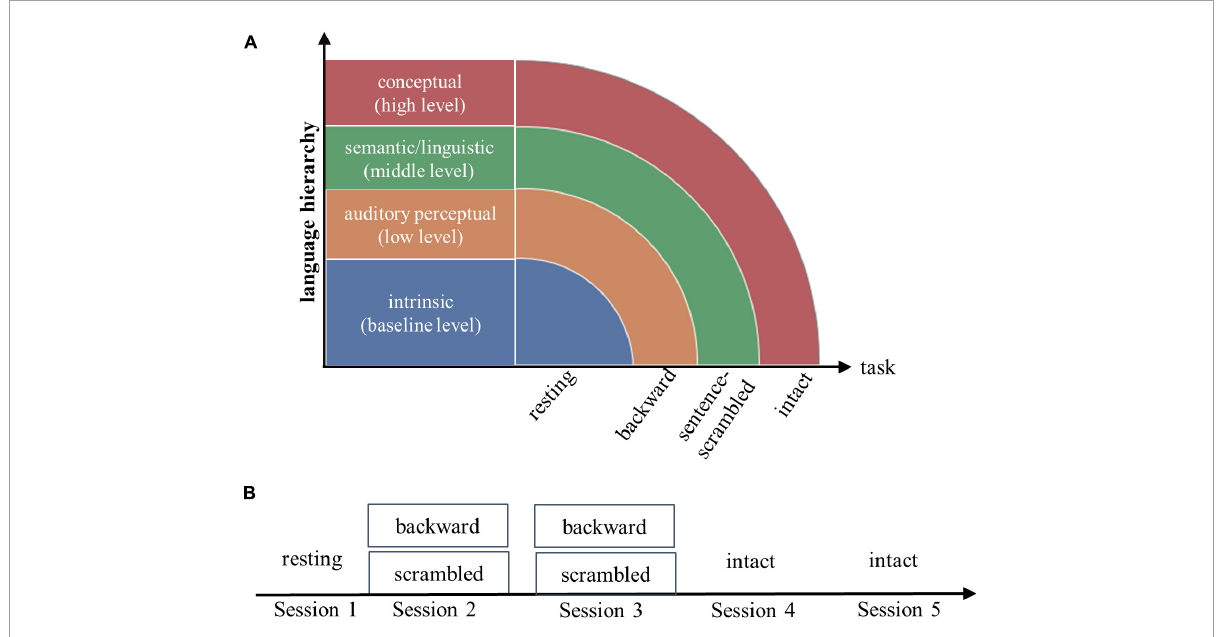
FIGURE1 Experimental design (A) and fMRI scanning scheme (B) . Each subject underwent a resting-state fMRI scanning, then followed by three tasks: listening to short stories presented waveform-reversed in time (backward), stories scrambled at the sentence level, and stories played forward (intact). The resting state and three tasks were assumed to engage increasingly complex processes along the language hierarchy. For each of the three tasks, the brain imaging data were collected from two successive scan